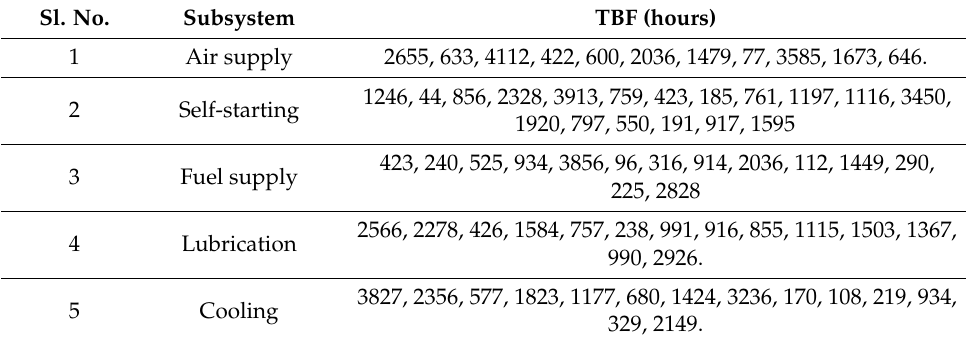
Table 6. Grouped TBF data for engine subsystems.